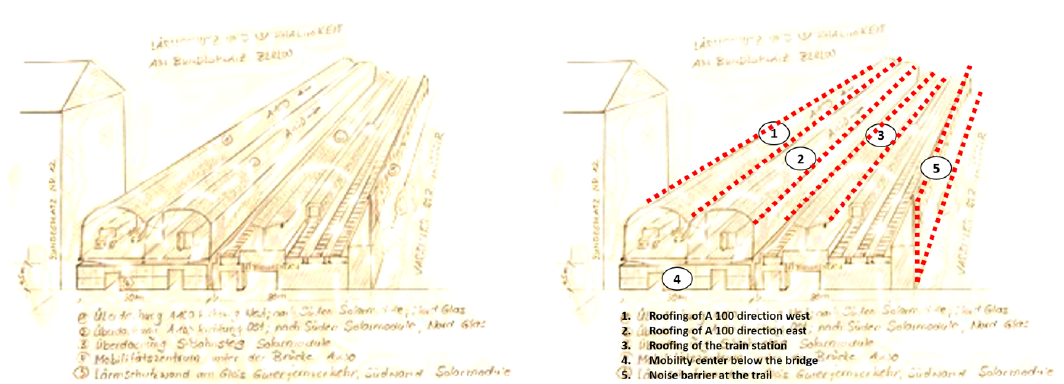
Figure 5. Drawings (authors’ own translation). Edited by the authors based on images from the ‘meinBerlin’ platform.